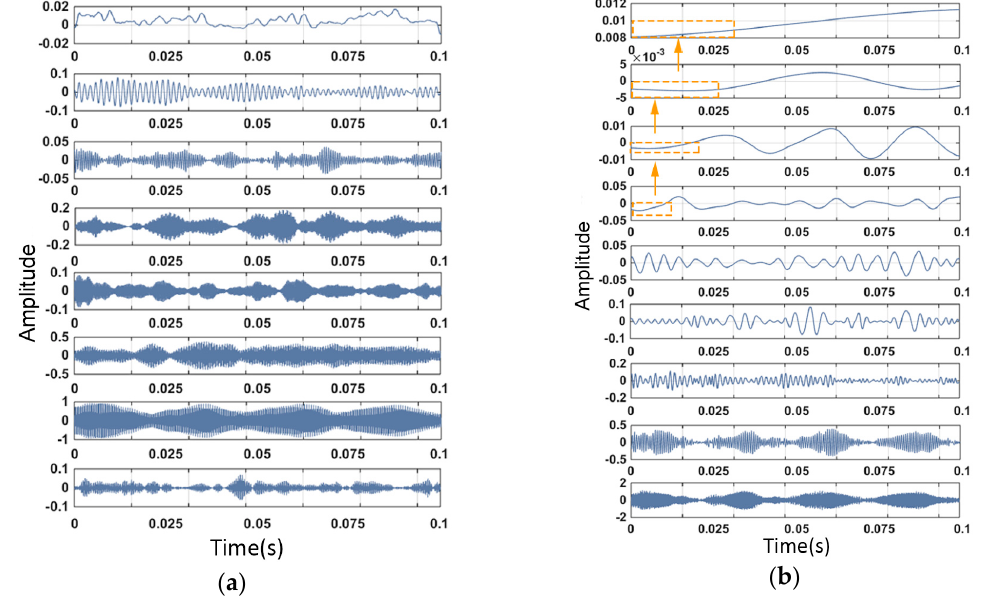
Figure 2. Comparison of time-domain signals of ( a ) the VMD (variational mode decomposition) method and ( b ) the EMD (empirical mode decomposition) method.